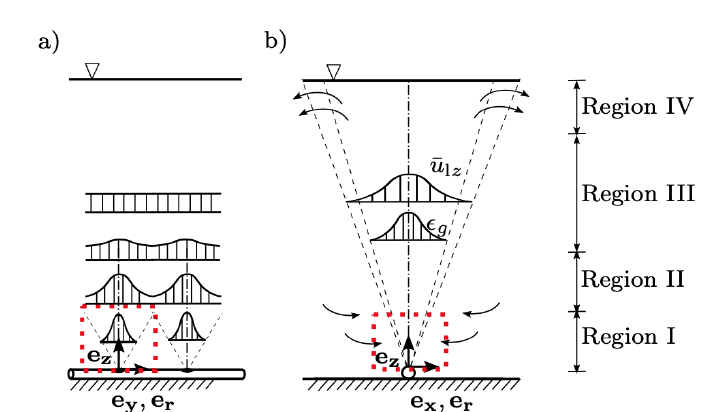
Figure 3. Schematic representation of the vertical mean liquid flow: ( a ) velocity field and ( b ) velocity field and the gas fraction in the x,z-plane of the bubble curtain. The dashed line denotes the estimated boundary of the flow field. The red box marks the region in which the formation process is examined